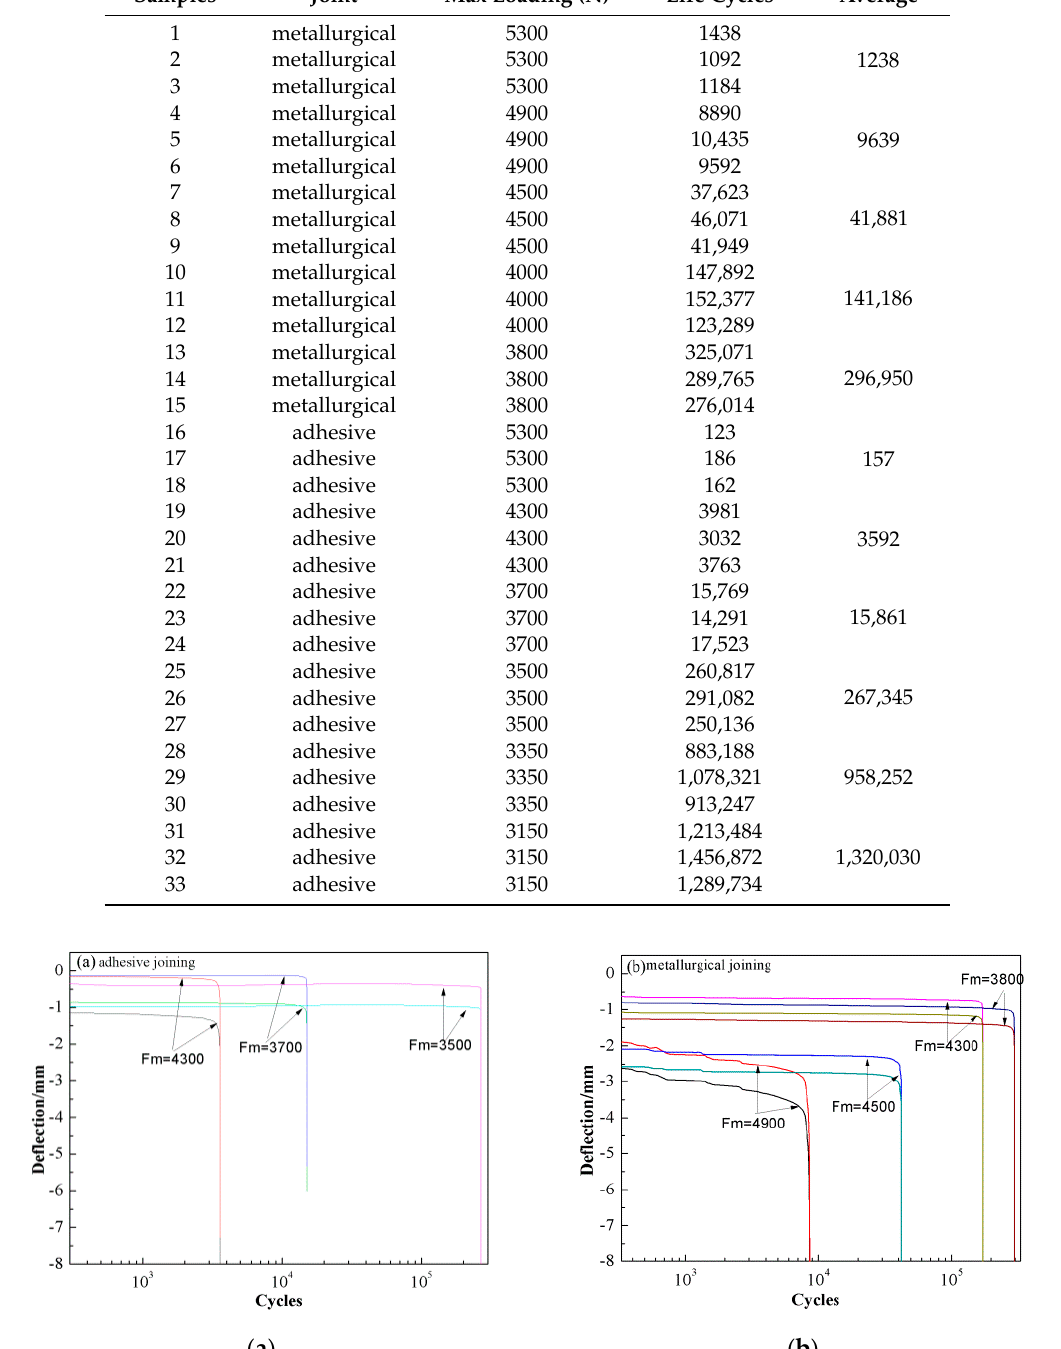
Table 2. Experimental data for three-point bending fatigue.